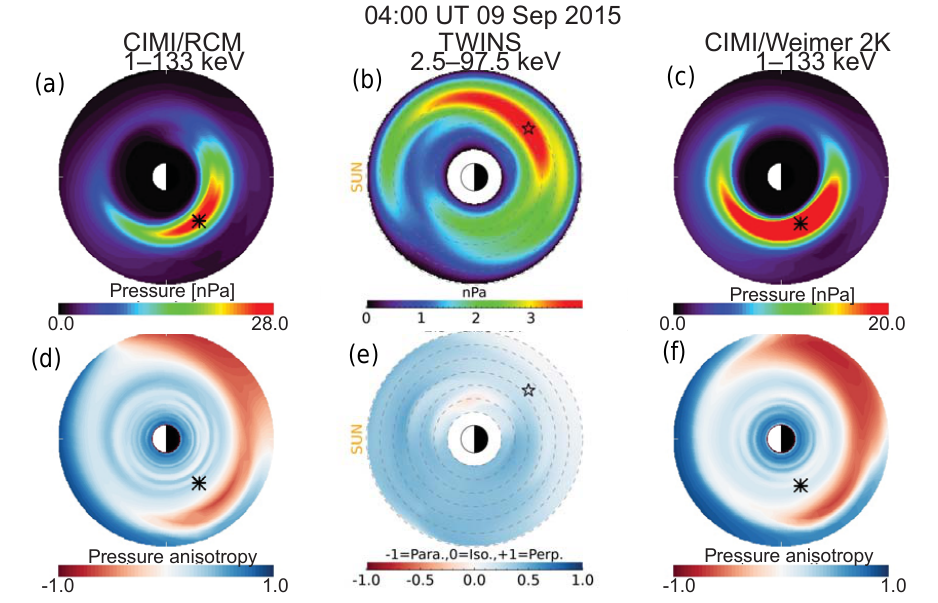
Figure 7. The ion equatorial pressure and pressure anisotropy for 04:00UT 9 September 2015 in the same format as Fig. 3.